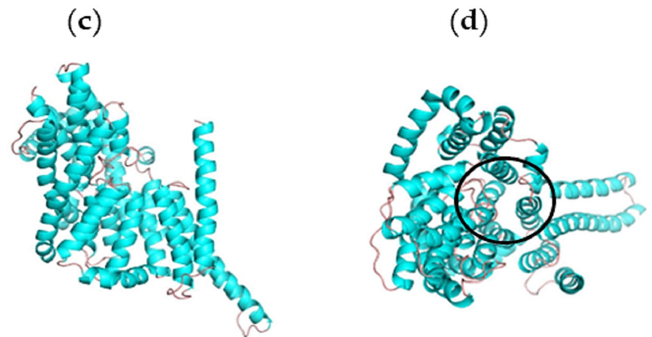
Figure 2. Predicted 3D structure models of target proteins. ( a ) Side view and ( b ) top view of the MT model, as well as ( c ) side view and ( d ) top view of the SoDIT-a model. Based on the high homology of the MT and SoDIT-a templates (specifically 3M71 and 4F35), multimeric structural models of these proteins could be predicted according to their